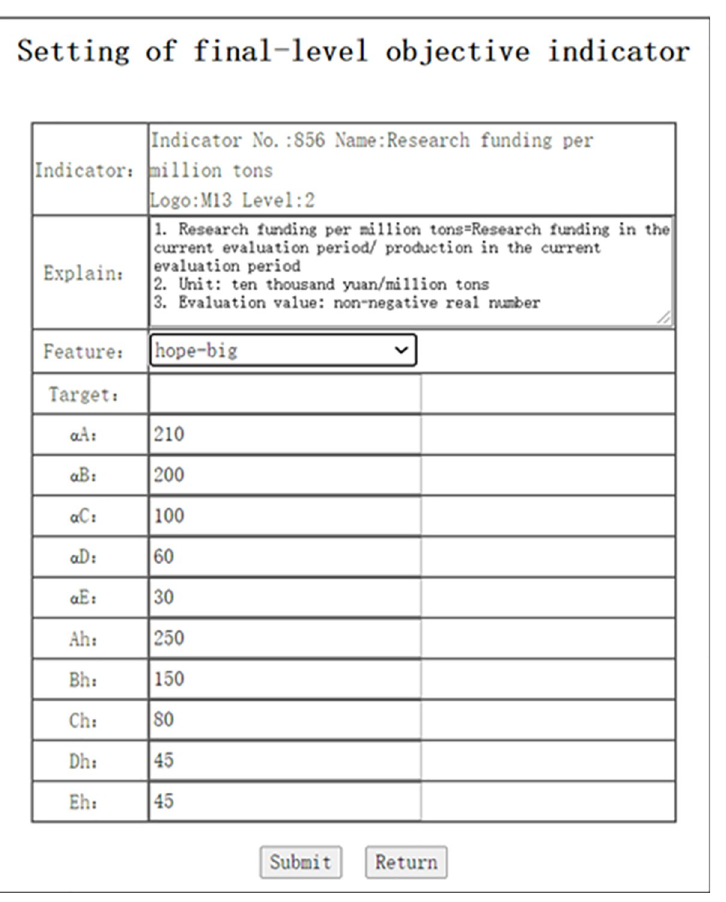
Fig 11. Setting of final-level objective indiator (Indicator No.: 856).